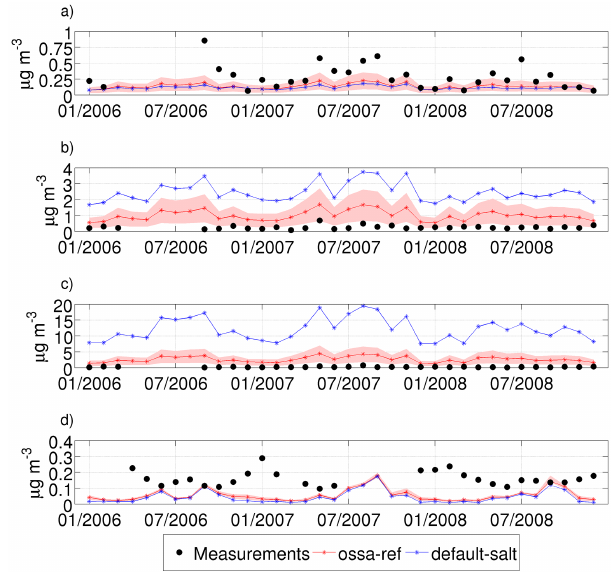
Figure 7. Measured and modelled monthly mean mass concen- tration of the sodium ion in three different size ranges: (a) PM 1 , (b) PM 1–2.5 , and (c) PM 2.5–10 , and (d) total carbonaceous aerosol (in PM 1 ) at Amsterdam Island. The shaded area around the red line corresponding to ossa-ref represents the uncertainty from the sensi- tivity runs.